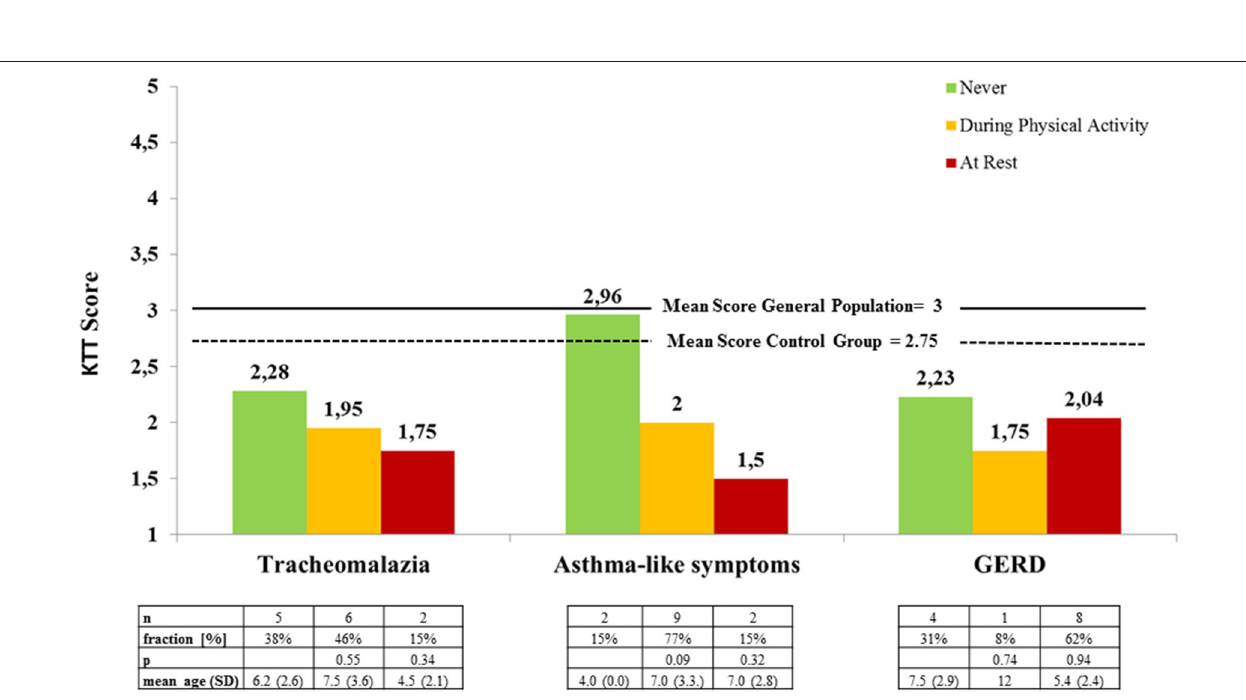
Frontiers in Pediatrics |